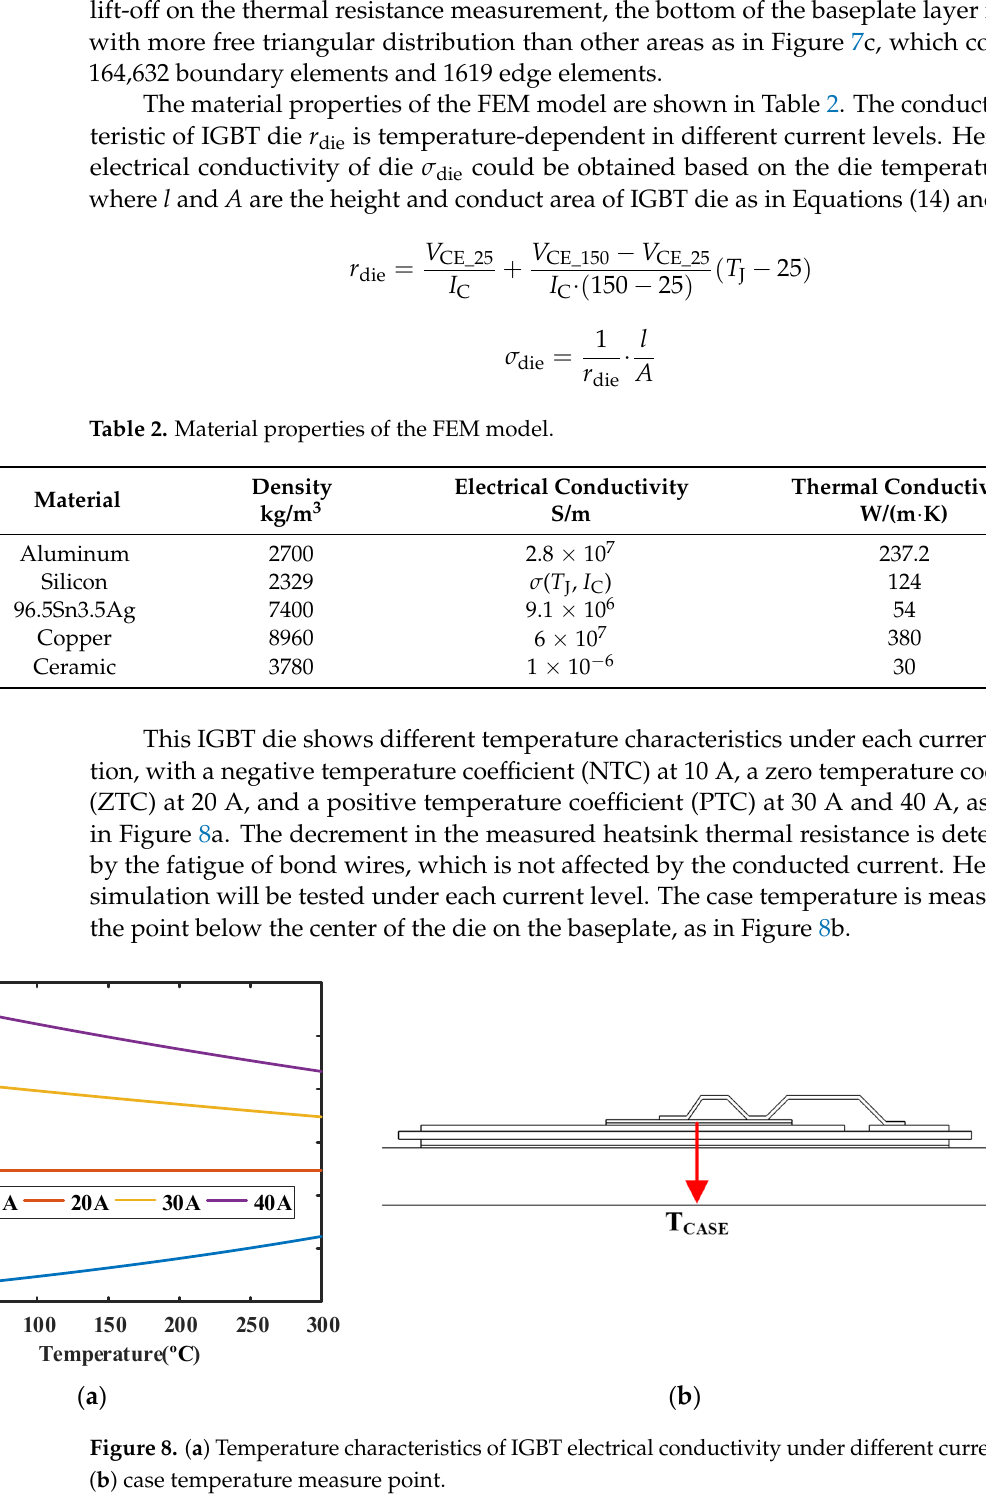
Figure 8. ( a ) Temperature characteristics of IGBT electrical conductivity under different current levels; ( b ) case temperature measure point.